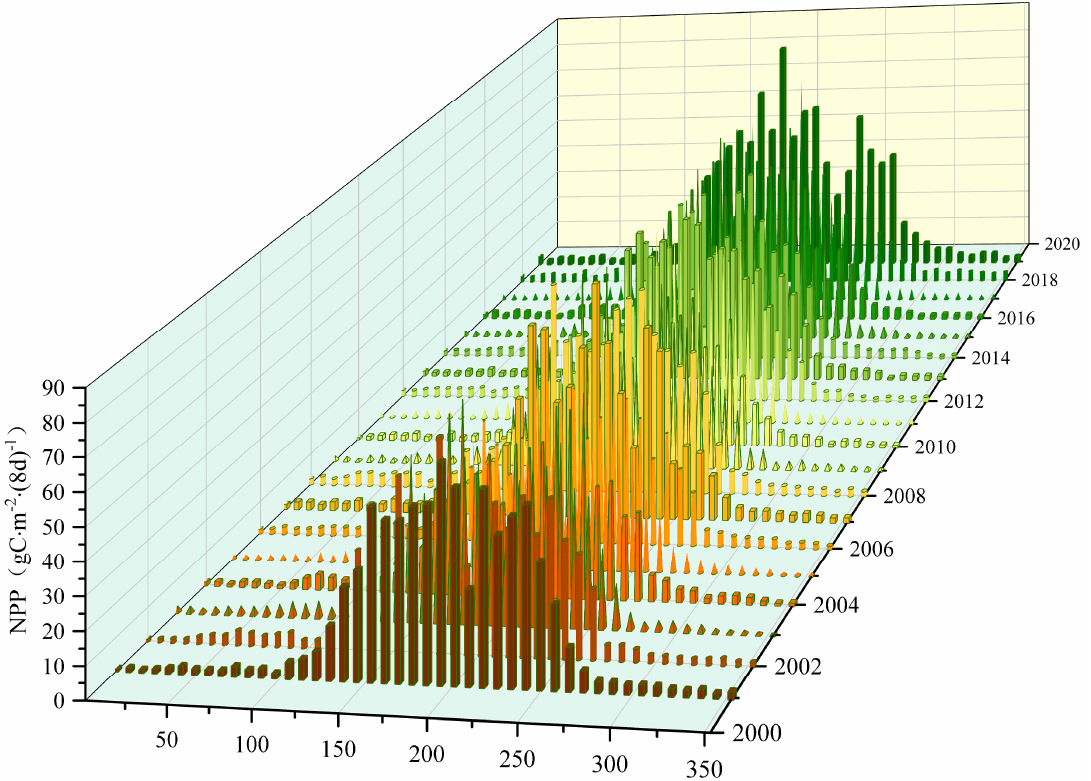
Figure 11. The changing trend of forests NPP, every eight days, from 2001 to 2019, in Northeast China.